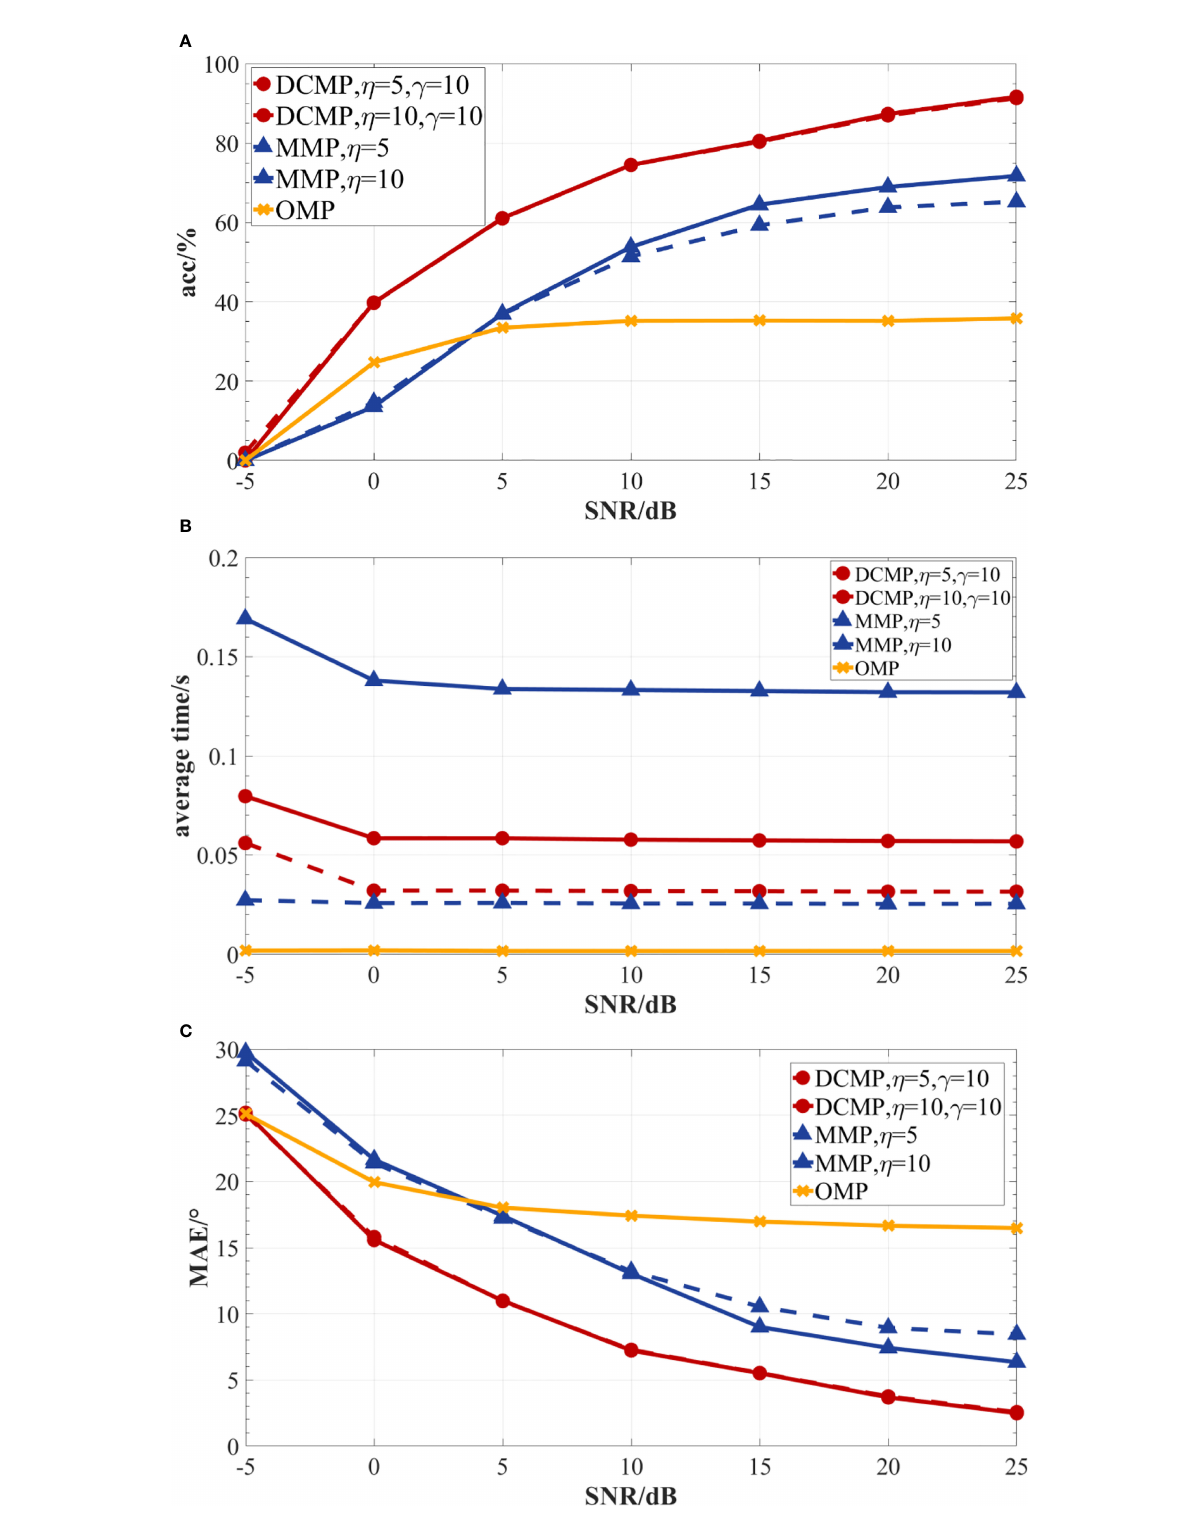
FIGURE 9 The performances of the DCMP, MMP, and OMP algorithms under different SNR values for three sources, a 12-element array, and 96 snapshots. (A) DOA prediction accuracy; (B) average estimation time; (C)